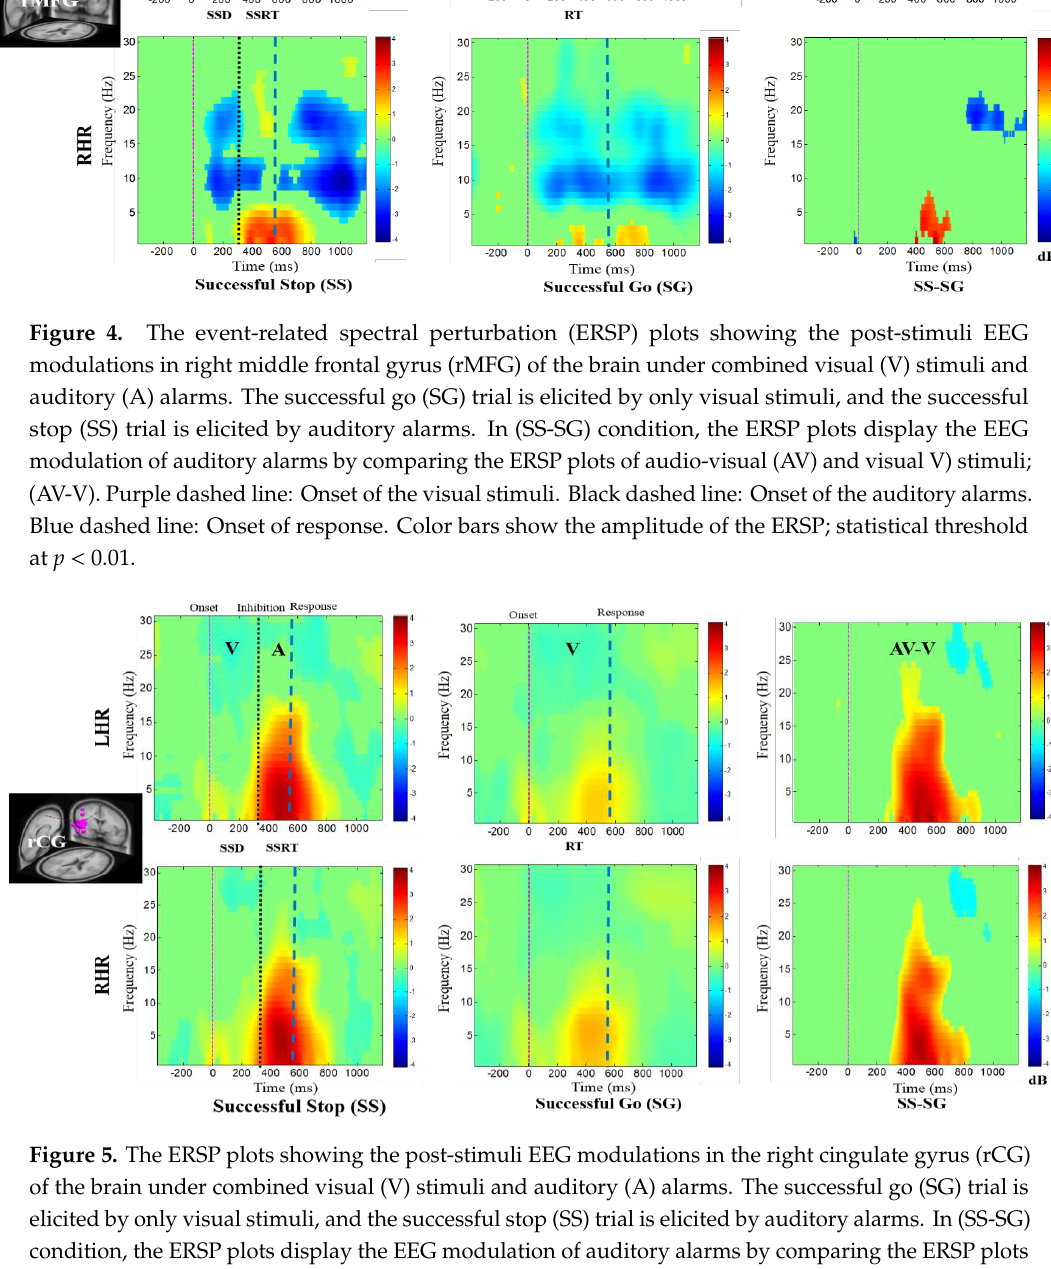
Figure 5. The ERSP plots showing the post-stimuli EEG modulations in the right cingulate gyrus (rCG) of the brain under combined visual (V) stimuli and auditory (A) alarms. The successful go (SG)